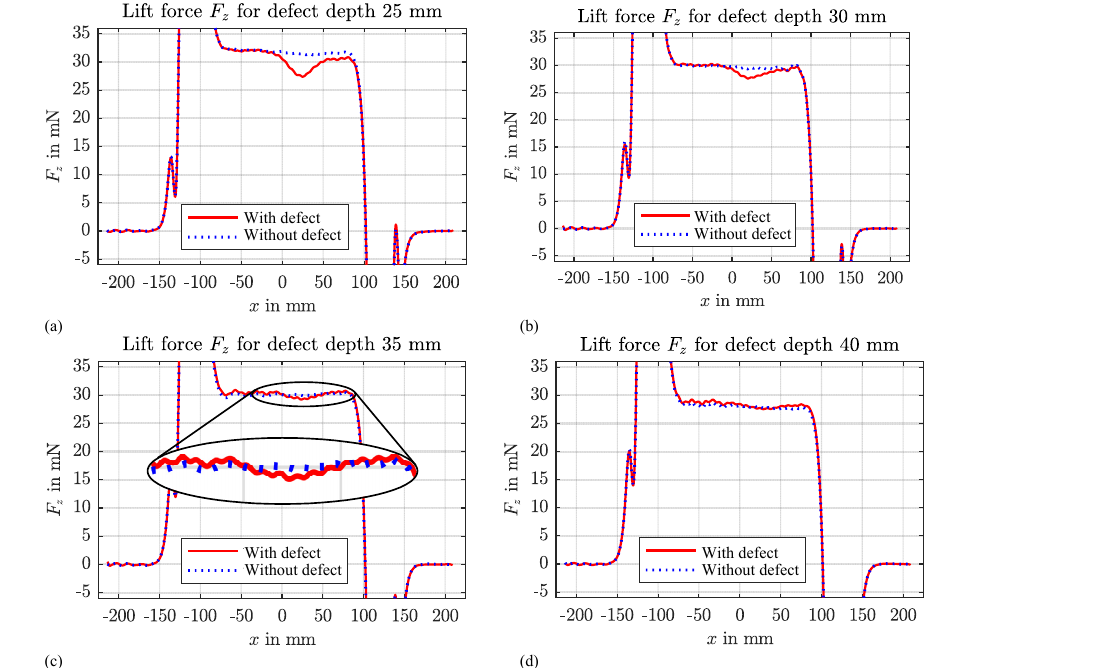
Figure 4. Measurement results of the lift force F z with (solid red line) and without a defect (dotted blue) for the defect depths d = 25mm, d = 30mm, d = 35mm, and d =